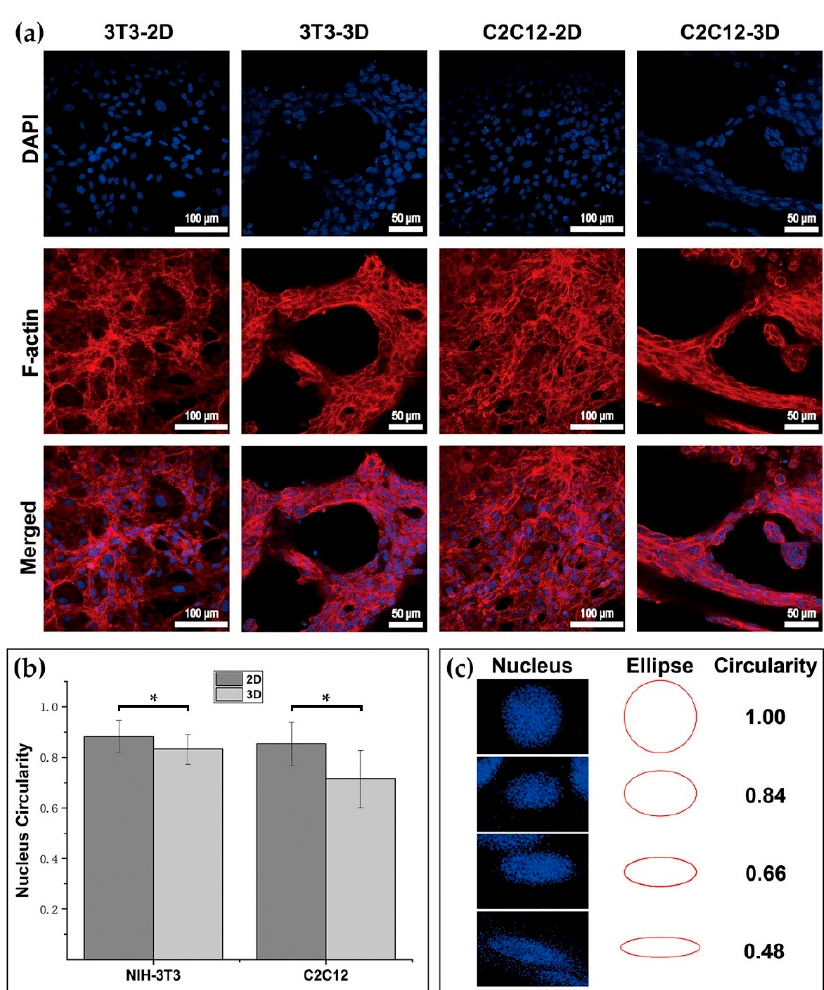
Figure 7. Cytoskeletal staining and analysis for cells in 2D and 3D. ( a ) DAPI and F-actin staining of 3T3 and C2C12 cells in 2D and 3D culture; ( b ) Circularity of cellular nucleus in 2D petri dishes and 3D dextran hydrogel. The data were presented by mean ± SD; * p < 0.05 versus the corresponding 2D control samples. ( c ) Demonstrations of estimating the circularity of cell nucleus.